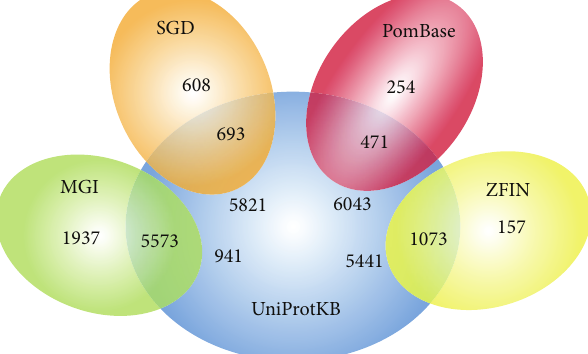
Figure 5: Venn diagram comparing the top 100 cooccurring terms returned by GOLink and QuickGO given similar input parameters. As expected there is a high level of overlap in the terms returned by both lists with discrepancies arising as a result of differences in the underlying databases used by the two